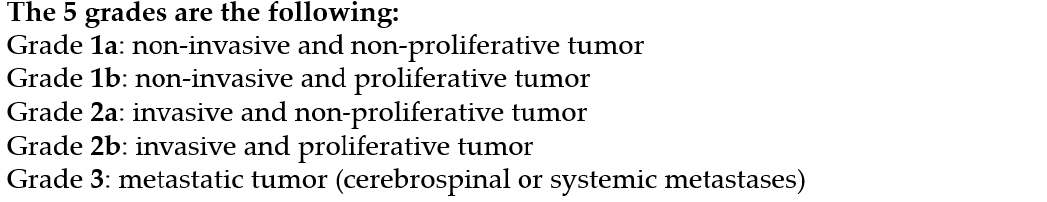
Figure 1. Five-Tiered prognostic classification of PitNETs